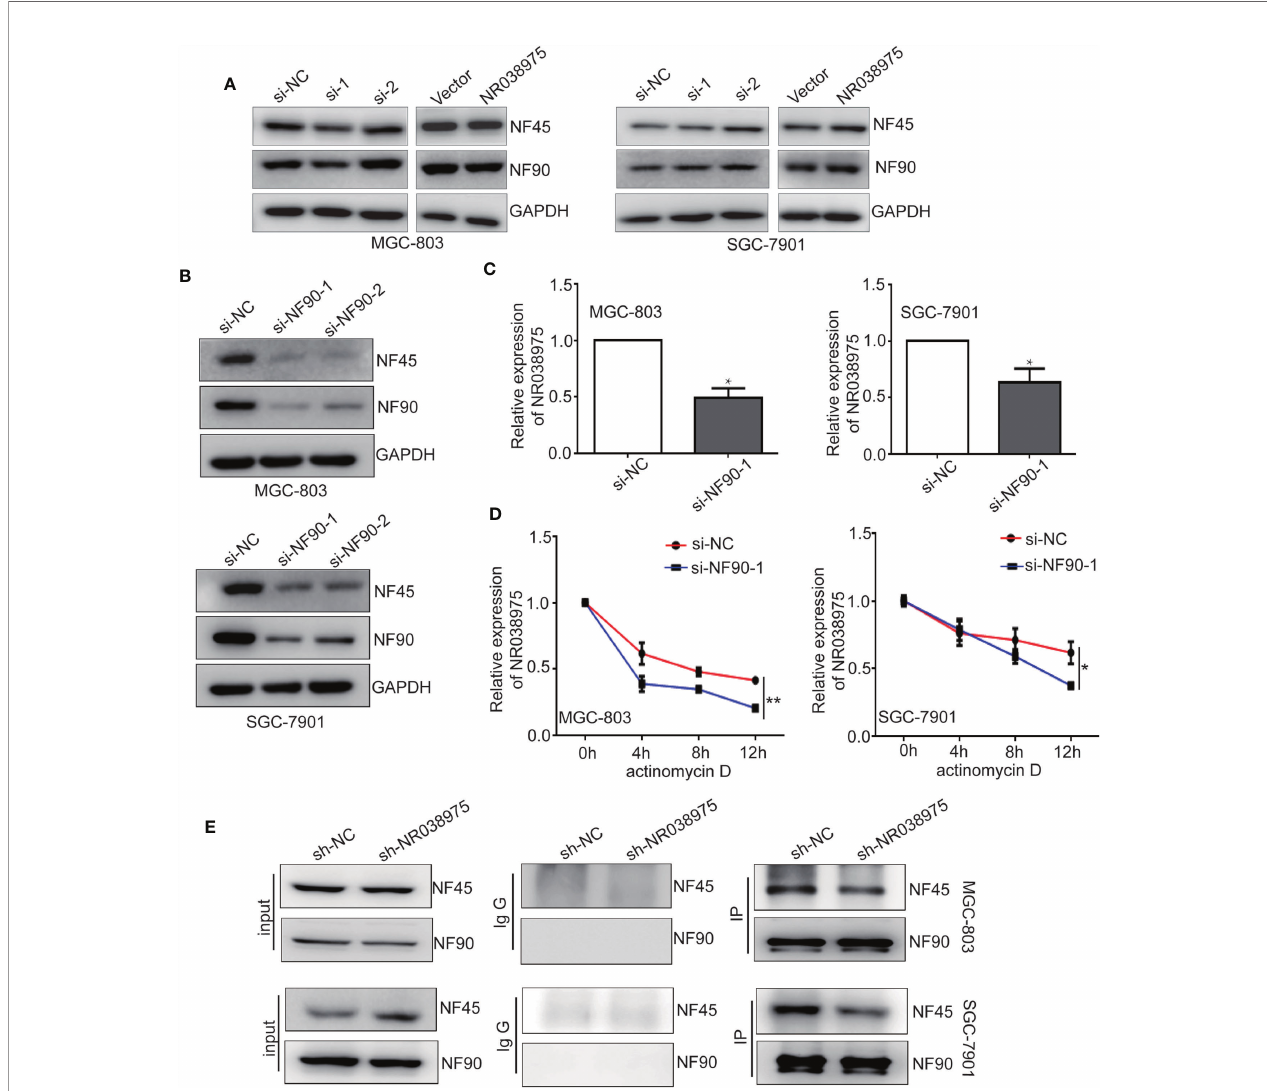
FIGURE 5 | Long noncoding RNA (lncRNA) NR038975 directly links NF45 and NF90. (A) NF90 and NF45 expression levels were measured through Western blotting after knockdown or overexpression of NR038975. (B) NF90 and NF45 expression levels were measured through Western blotting after knockdown of NF90. (C) NR038975 expression level was measured by real-time PCR after knockdown of NF90, *p < 0.05. (D) The half-life of NR038975 after treatment with 5 m g/ml actinomycin D for indicated times, with NF90 knockdown in MGC-803 and SGC-7901 cells, *p < 0.05. (E) Immunoprecipitation assay was performed to detect the interaction between NF90 and NF45 in NR038975-stably knockdown MGC-803 and SGC-7901 cells, **p <